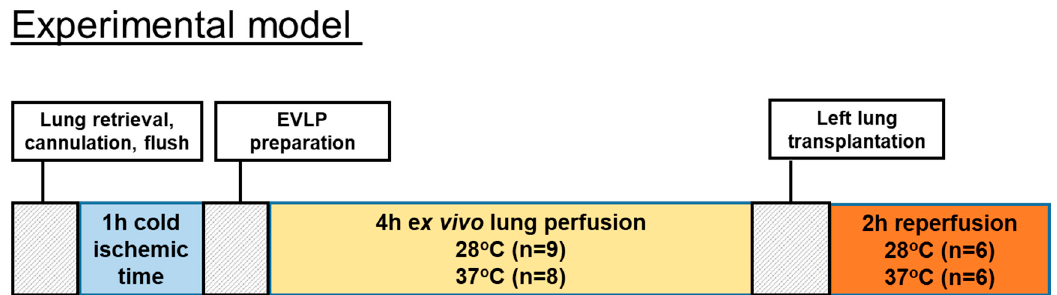
Figure 1. Timeline of the animal study.